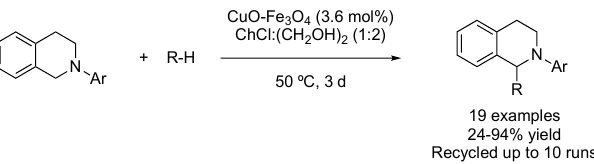
Figure 29. Cross-dehydrogenative coupling of 1,2,3,4-tetrahydroisoquinolines.